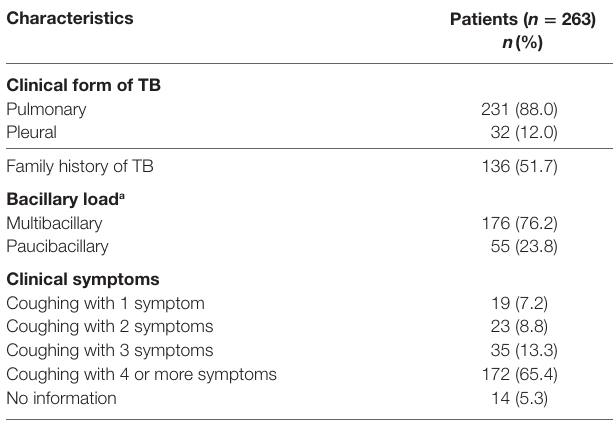
TaBle 2 | Clinical characteristics of the patients with